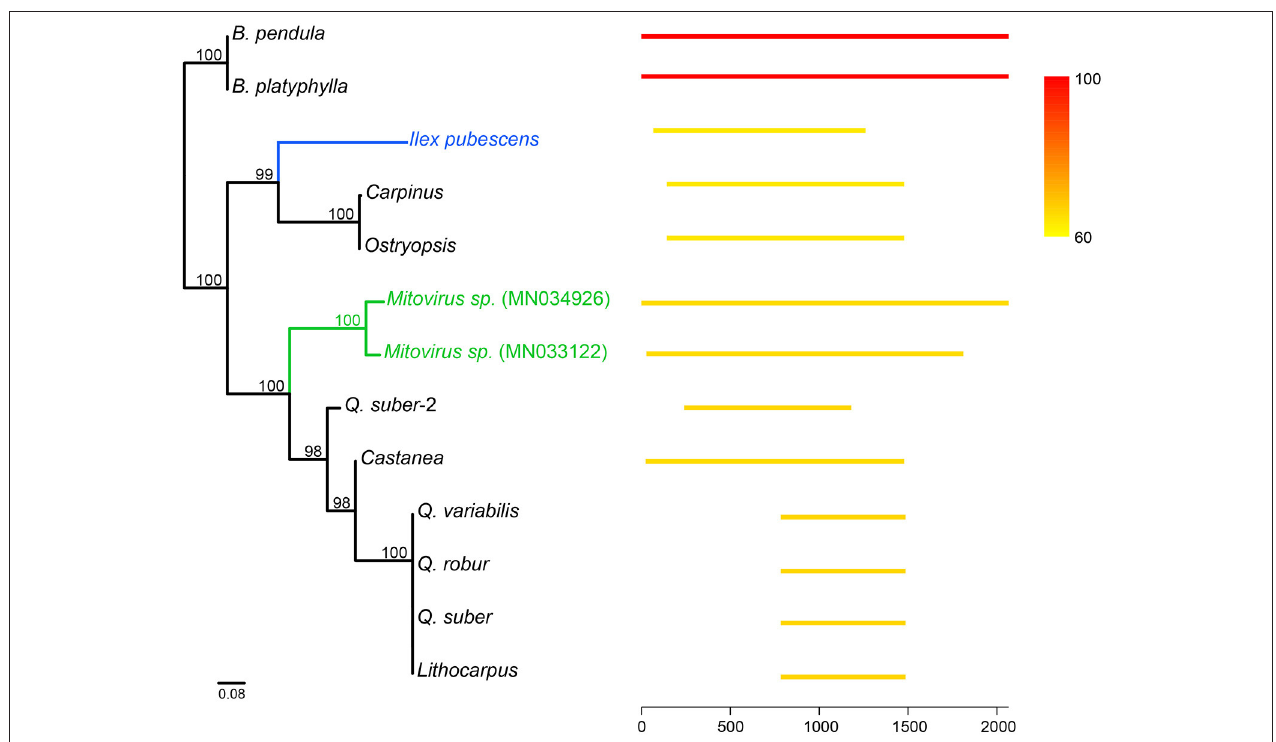
FIGURE 5 | Mitovirus-like sequences in Fagales and other species. Long hits ( > 700 bp) were retrieved by searching the mitovirus-like sequence in Betula against NCBI nt database and other Fagales mitogenomes. At the right, lines show the position of the hits, and color indicates the similarity compared to the mitovirus-like sequence in Betula (red lines). The left tree was constructed by these hits using the ML method. The blue and green colors on the tree highlighted Ilex and mitoviruses,